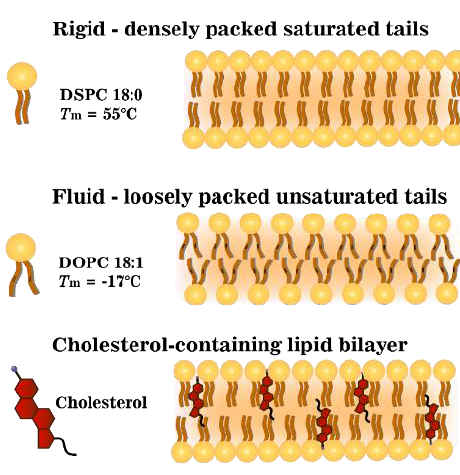
Table 2. All formulations contain 4 mol % of DSPE-PEG 2000 . For the sake of clarity, hereinafter, this component will no longer be shown in the sample names used in the text.